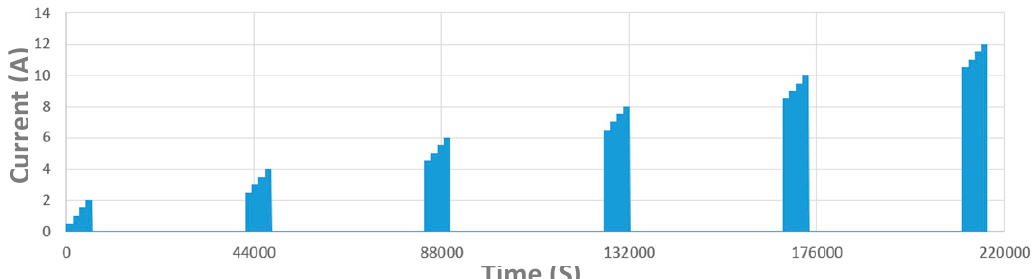
Table 2. The setting of individual sequences of regeneration algorithm for short-circuited cell.